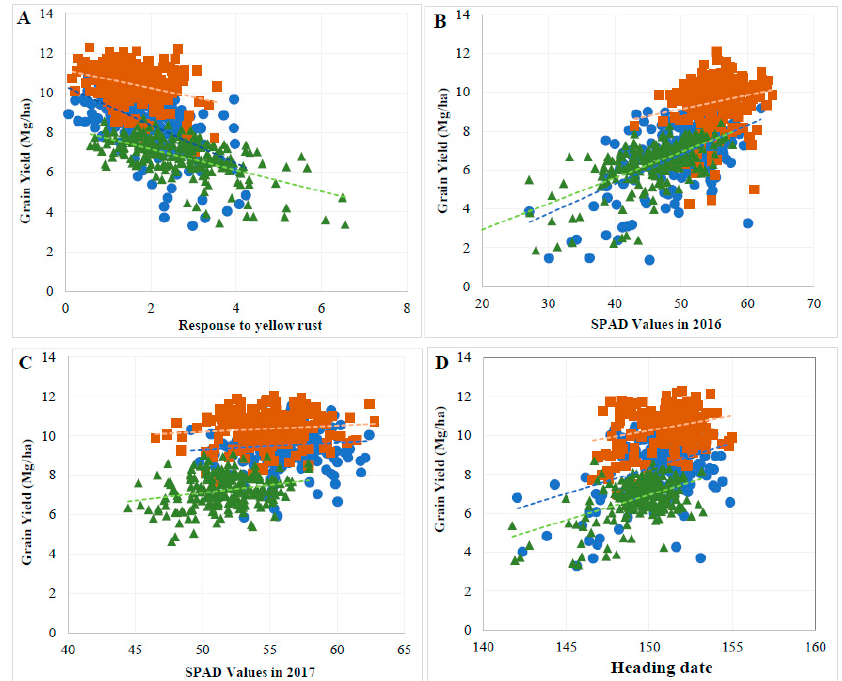
Figure 4. Relationship between GY and traits of interest under three CS. ( A ) Response to yellow rust scored in 2015 and 2016 seasons. ( B ) SPAD in 2016. ( C ) SPAD in 2017. ( D ) Heading date of three years averaged per cultivars. Color-shape symbols: green-triangle for the cropping system LN-NF, blue-circle for HN-NF, and red-square for HN-WF. The regressions equations, the signifi- cance of the slopes and comparison among slopes of the three CS is given Table S12.